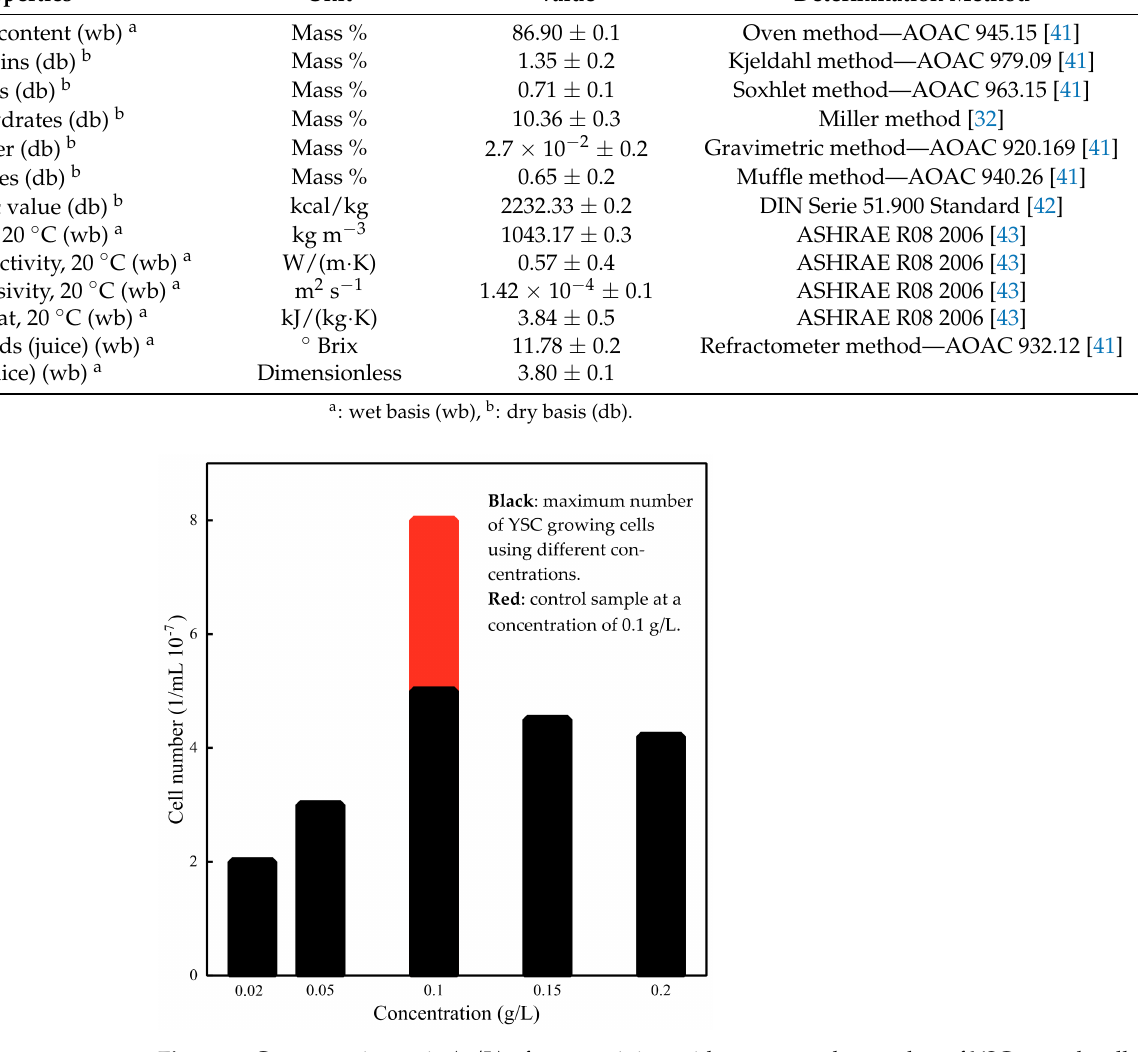
Figure 2. Concentration ratio (g/L) of pomace juice, with respect to the number of YSC growth cells at 100 rpm and 30 ◦